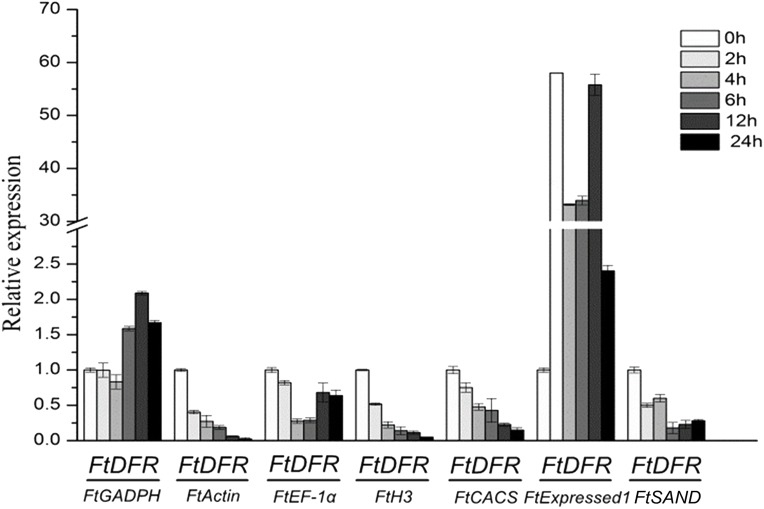
Relative quantification of FtDFR gene expression under UV treatment in tartary buckwheat hypocotyls.Error bars represent standard deviation of the mean, data shown are means ± SD (n = 3).